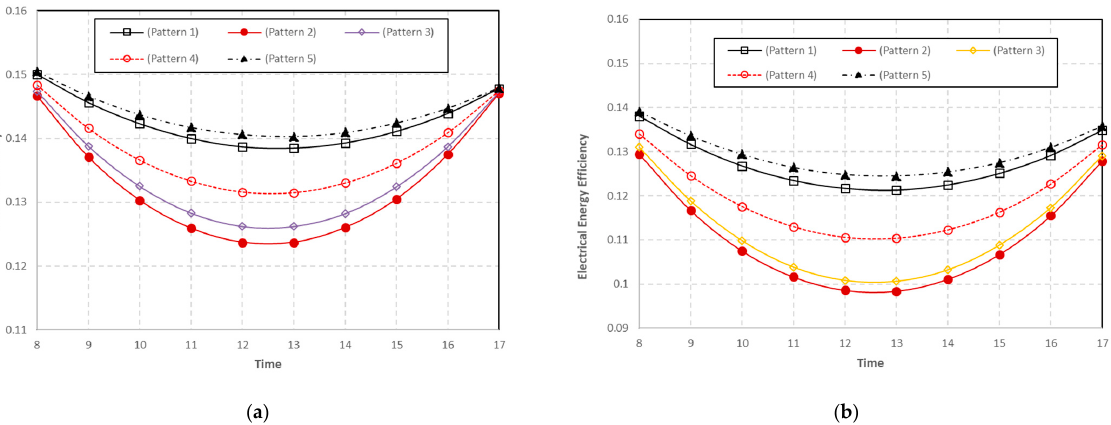
Figure 13. Hourly variations in efficiency of electrical energy for different configurations. ( a ) during Winter day ( b ) during Summer